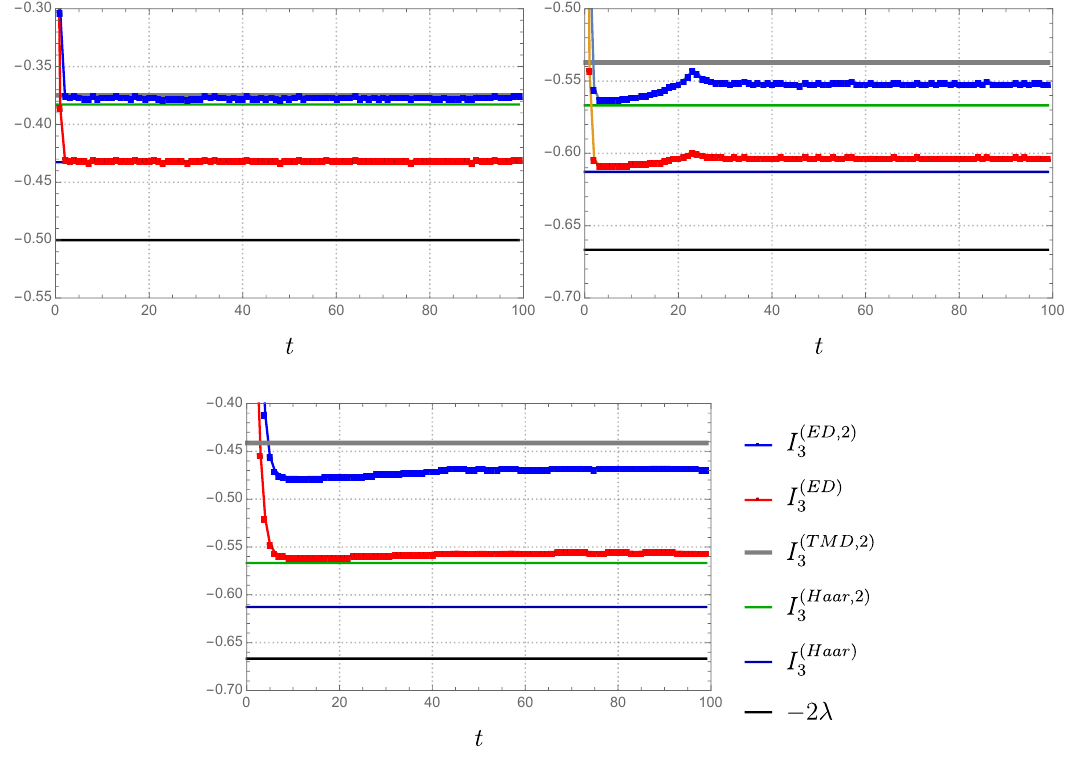
( A ; C , D ) (blue squares) for the SYK ( A ; C , D ) (red squares) and I ( 2 ) Figure 5: Plots of I 3 3 models with different system sizes. Top Left: Majorana SYK with N = 8, where the = 2, N = N = 4. Note that I ( TMD ,2 ) energy spectrum has no degeneracy. N and A C D 3 ( ED ,2 ) the actual numerical data I are barely distinguishable. Top Right: Majorana 3 SYK with N = 12, where the energy spectrum is doubly degenerate everywhere. = 4, N = N = 6. Bottom: complex SYK with N = 6, where the energy spectrum N A C D = 2, N = N = 3. In every plot, each data is doubly degenerate everywhere. N A C D point (squares), as well as the result from equilibrium approximation using TMD state (gray line), are obtained from averaging over 1000 disorder